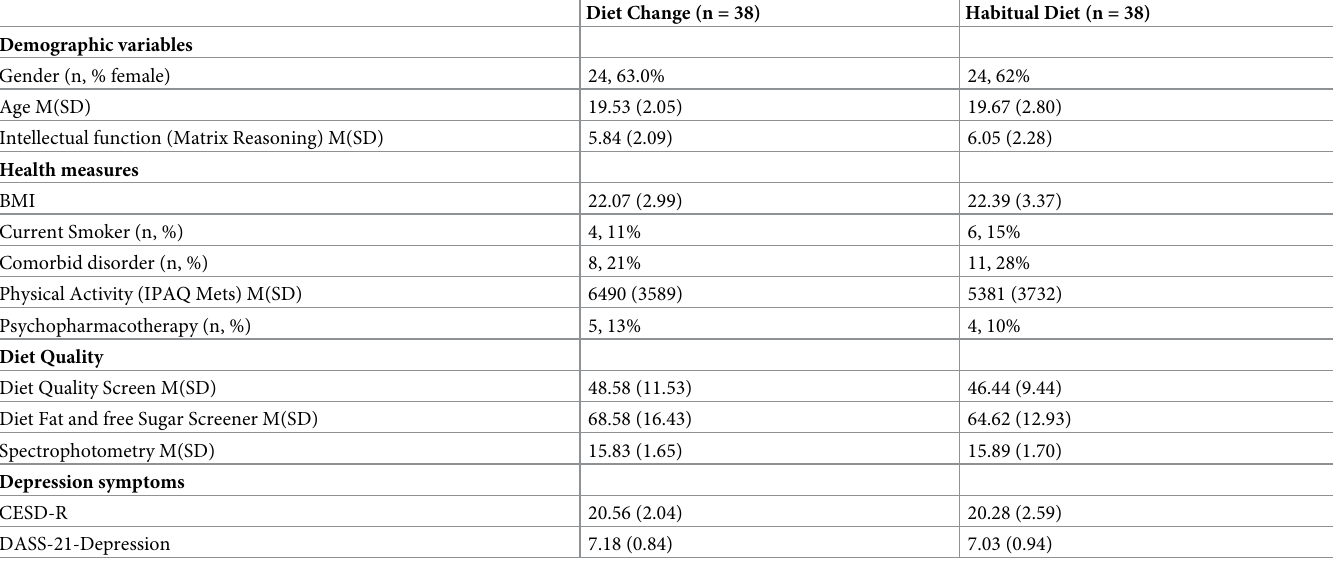
Table 1. Baseline characteristics of individuals in the diet change (n = 38) and habitual diet (n = 38) groups.